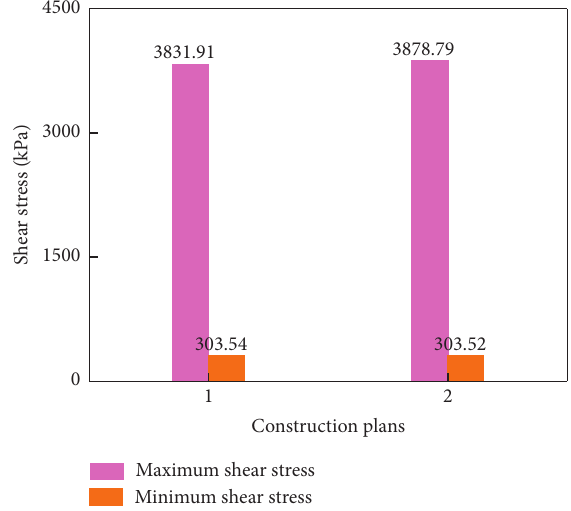
Figure 11: Maximum shear stress of the newly built